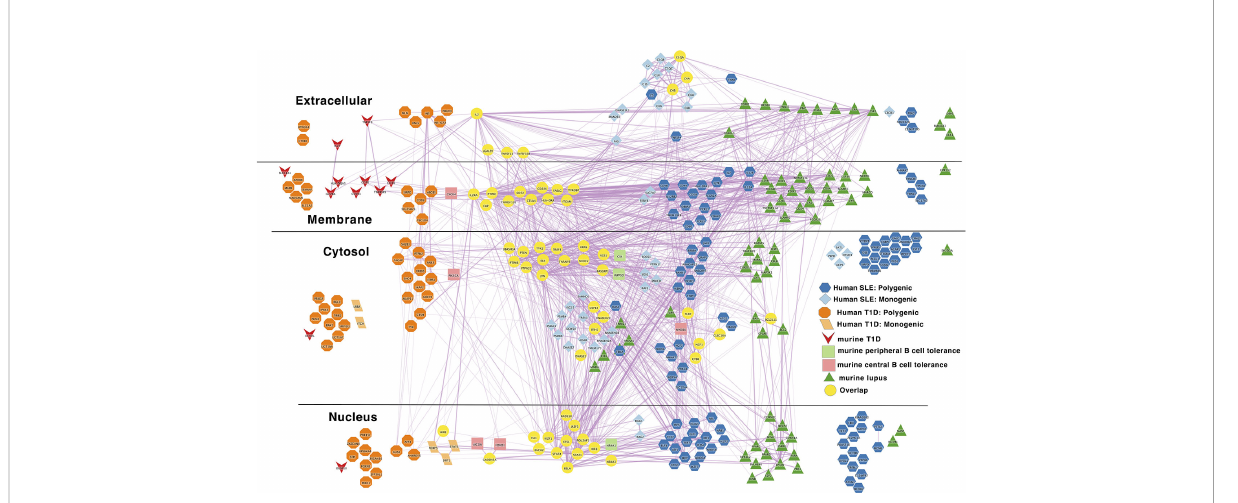
FIGURE 6 Murine autoimmune disease model genes center around the autoreactive B cell peripheral tolerance network in the middle of combined human autoimmune disease polygenic risk networks. Light blue diamond – Monogenic human SLE gene; dark blue hexagon – Polygenic human SLE gene; dark green triangle – murine lupus gene; light green rounded rectangle – murine peripheral B cell tolerance gene; light red rectangle – murine central B cell tolerance gene; dark red inverted triangle – murine autoimmune type 1 diabetes gene; light orange parallelogram – human monogenic autoimmune type 1 diabetes gene; dark orange octagon – human polygenic autoimmune type 1 diabetes gene; yellow circles – Overlapping genes. Downloadable/Interactive network diagram can be found at: